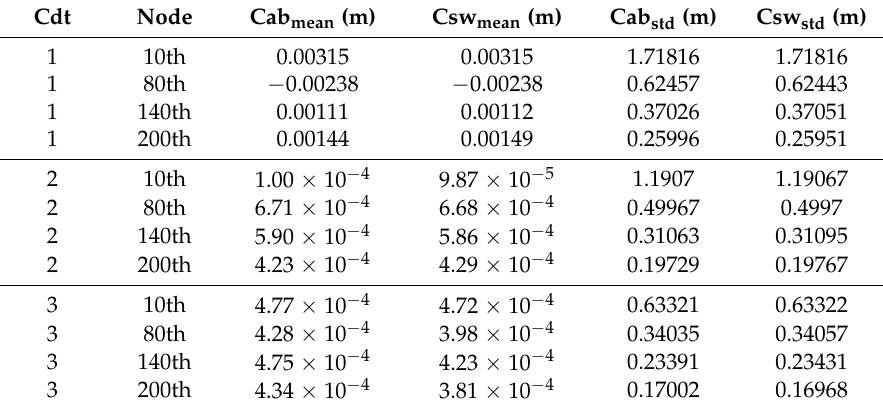
Table 8. Equilibrium and standard deviation of node